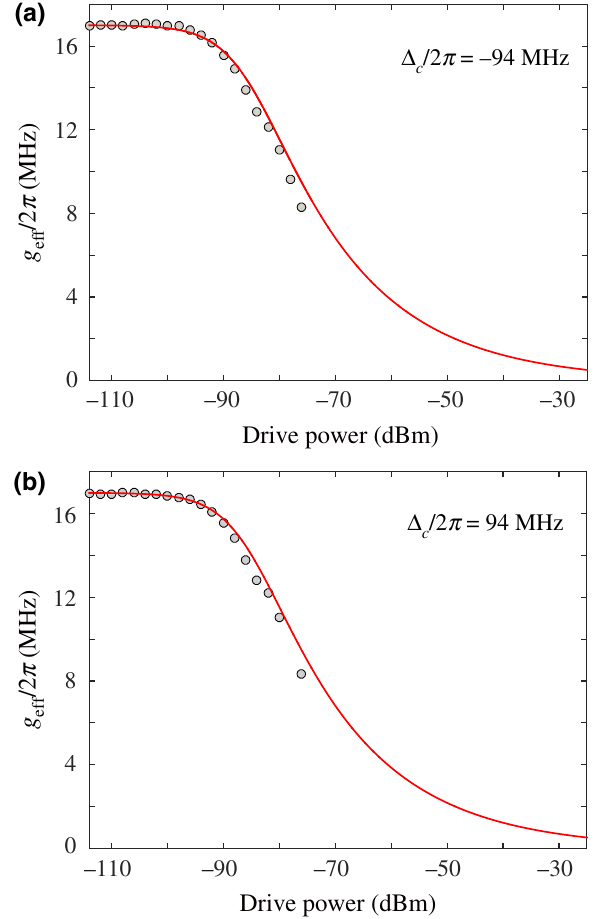
FIG. 9. The effective magnon-photon coupling versus the driv- ing power. (a) The data for g eff (circles) extracted from the Rabi splitting in Fig. 4(a) (see the main text), where the s = 0 subensemble is in resonance with the resonator mode and the s = + subensemble is resonantly pumped by a drive tone. The solid curve is calculated for g eff,+ using Eq. (D9) with (cid:18) c / 2 π = − 94 MHz. (b) The data for g eff (circles) extracted from the Rabi splitting in Fig. 4(b), where the s = 0 subensemble is in reso- nance with the resonator mode and the s = − subensemble is resonantly pumped by a drive tone. The solid curve is calcu- lated for g eff,- using Eq. (D9) with (cid:18) c / 2 π = 94 MHz. The other parameters are the same as in Fig.